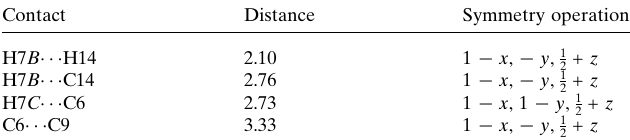
Table 2 Summary of short interatomic contacts (A˚ ) in (I).